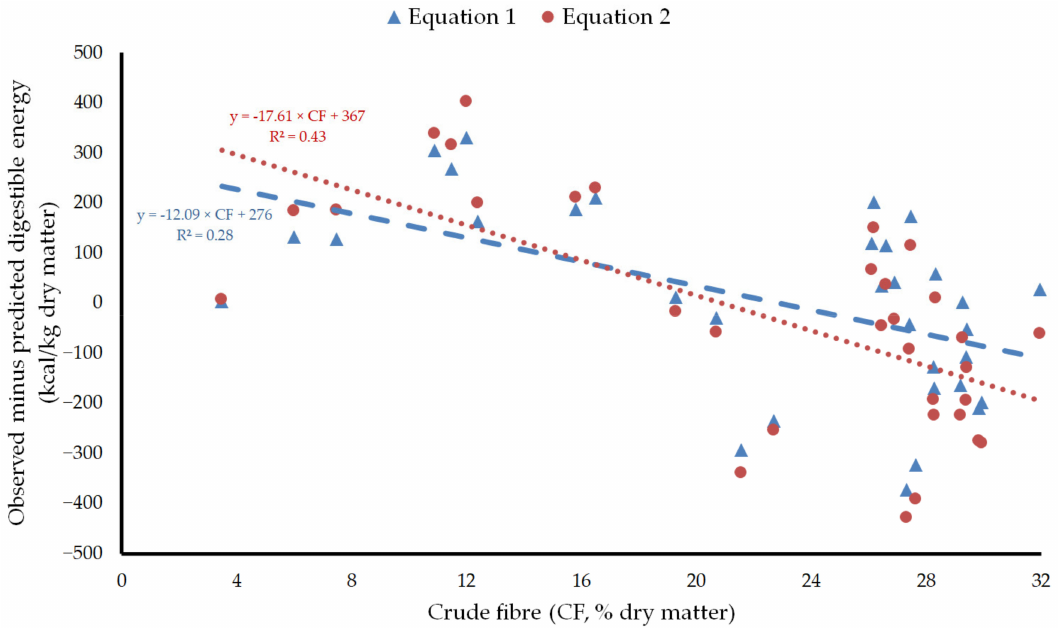
Figure 3. Plot of residuals versus crude fiber content in feeds. Equation 1: Equation of N ú ñez-S á nchez et al. [8]. Equation 2: Equation of Zeyner and Kienzle [14] modified, as presented in Kienzle and Zeyner